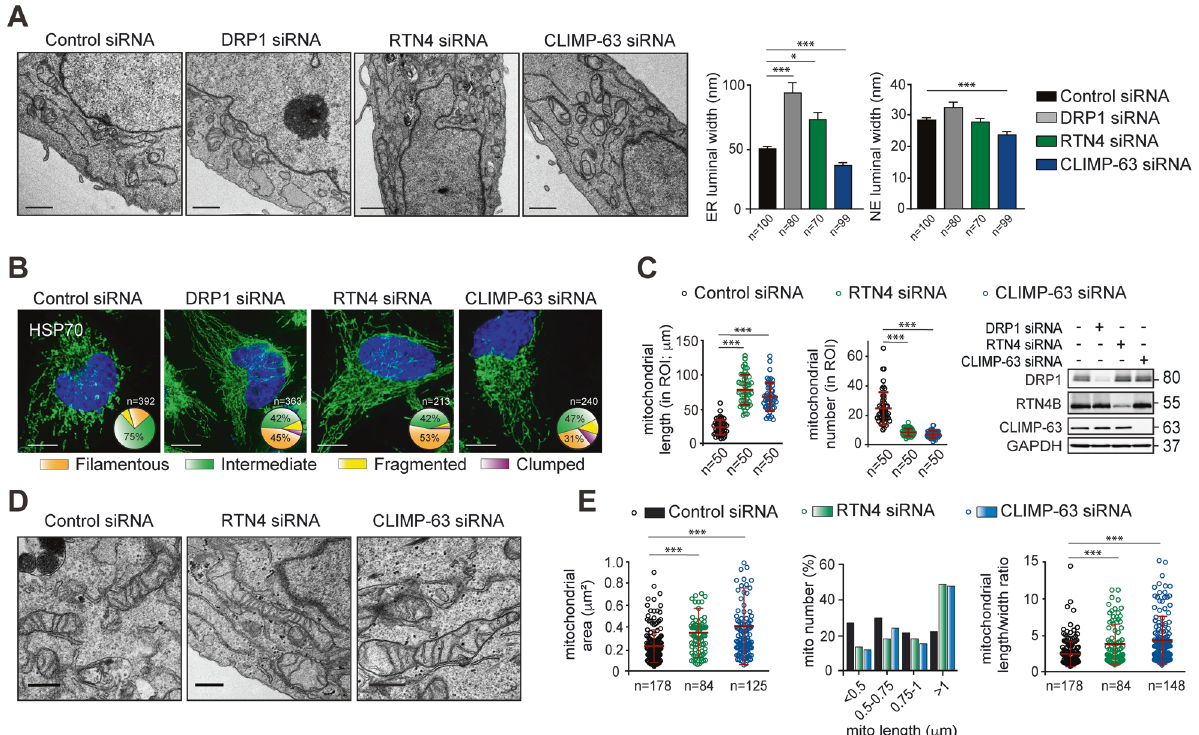
Fig. 2 ER shaping proteins, RTN4 and CLIMP-63, regulate ER and mitochondrial morphology. A Representative TEM images and graphs, showing ER and nuclear envelope (NE) width in HeLa cells transfected with a non-targeting control, DRP1, RTN4 or CLIMP-63 siRNA for 72 h. The number of ER or NE lumen used for width calculations are denoted as n numbers below the x axes. B HeLa cells were transfected with the indicated siRNAs for 72 h and immunostained for HSP70 (green) to visualise mitochondrial structure. Mitochondrial morphologies were quanti fi ed in the indicated numbers of cells per condition, across a minimum of 3 independent experiments, and the data plotted in pie charts here, and as bar graphs in Supplementary Fig. 13. Scale bars are 10 μ m. C Mitochondrial length ( μ m) and number were quanti fi ed in a de fi ned region of interest (ROI) from images of 50 cells ( n = 50) acquired as in B . Western blots show DRP1, RTN4 and CLIMP-63 knockdown ef fi ciencies for the indicated siRNAs. D TEM images of mitochondria in HeLa cells, transfected with the indicated siRNAs for 72 h. Scale bars are 500 nm. E Mitochondrial area ( μ m 3 ), length ( μ m), length/width ratio and number (%) were assessed by calculating these parameters from all mitochondria identi fi ed in the TEM images of at least 10 HeLa cells per siRNA. The number of mitochondria counted in each of these conditions are presented as n numbers below the x axes. Data are presented as A , mean ± SEM, or C and E , mean ± SD; * p ⩽ 0.05, *** p ⩽ 0.001 (Kruskal-Wallis tests, with Dunn ’ s multiple comparisons